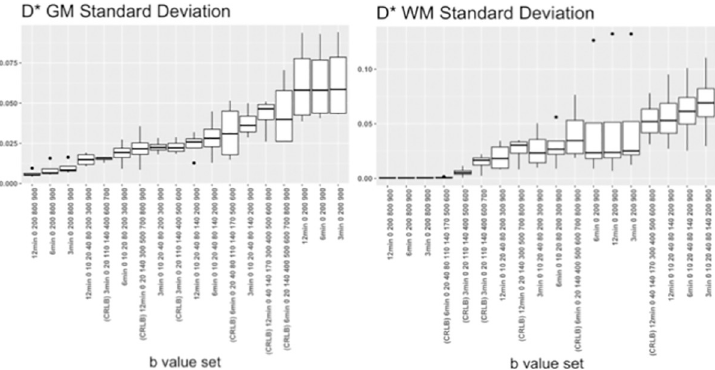
Fig 3. Standard deviations (SD) of IVIM parameter maps D � and f in brain grey and white matter over four healthy volunteers, using optimized b value distributions for optimized b value settings from analysis of direct SD measurements, and CRLB using noise estimates, for 3, 6, and 12 minutes scans.